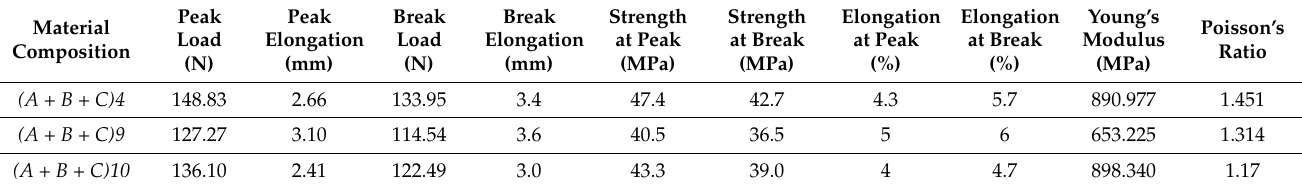
Table 13. Tensile testing of triple-sized particle reinforcements at different